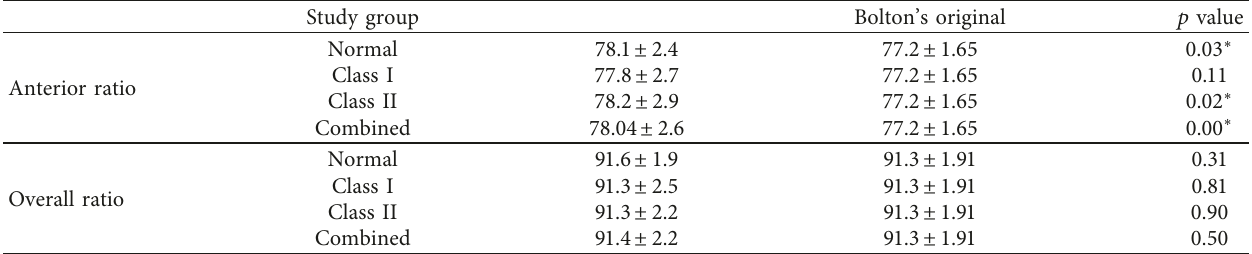
Table 6: Comparison of Bolton’s sample with the present study